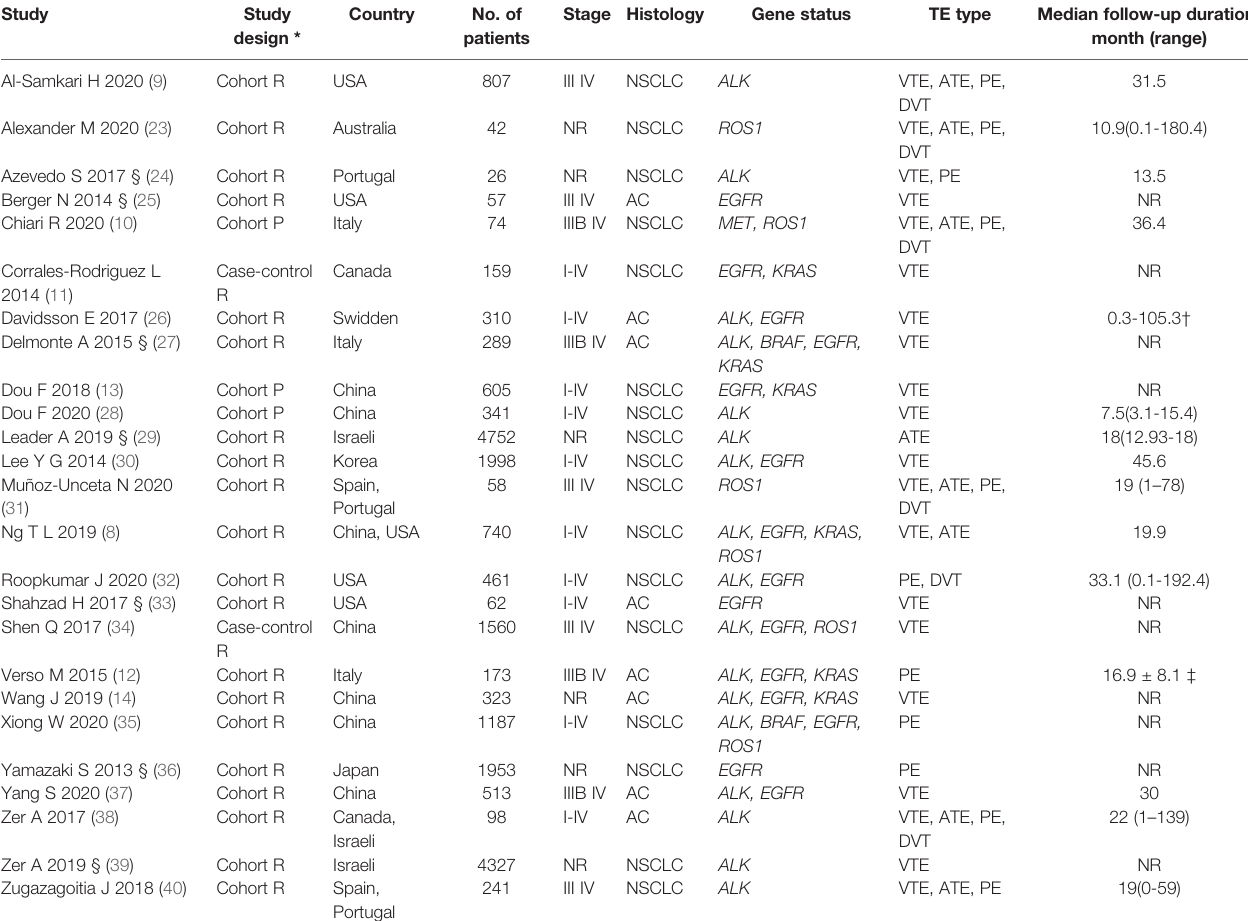
TABLE 1 | Characteristics of studies included in the